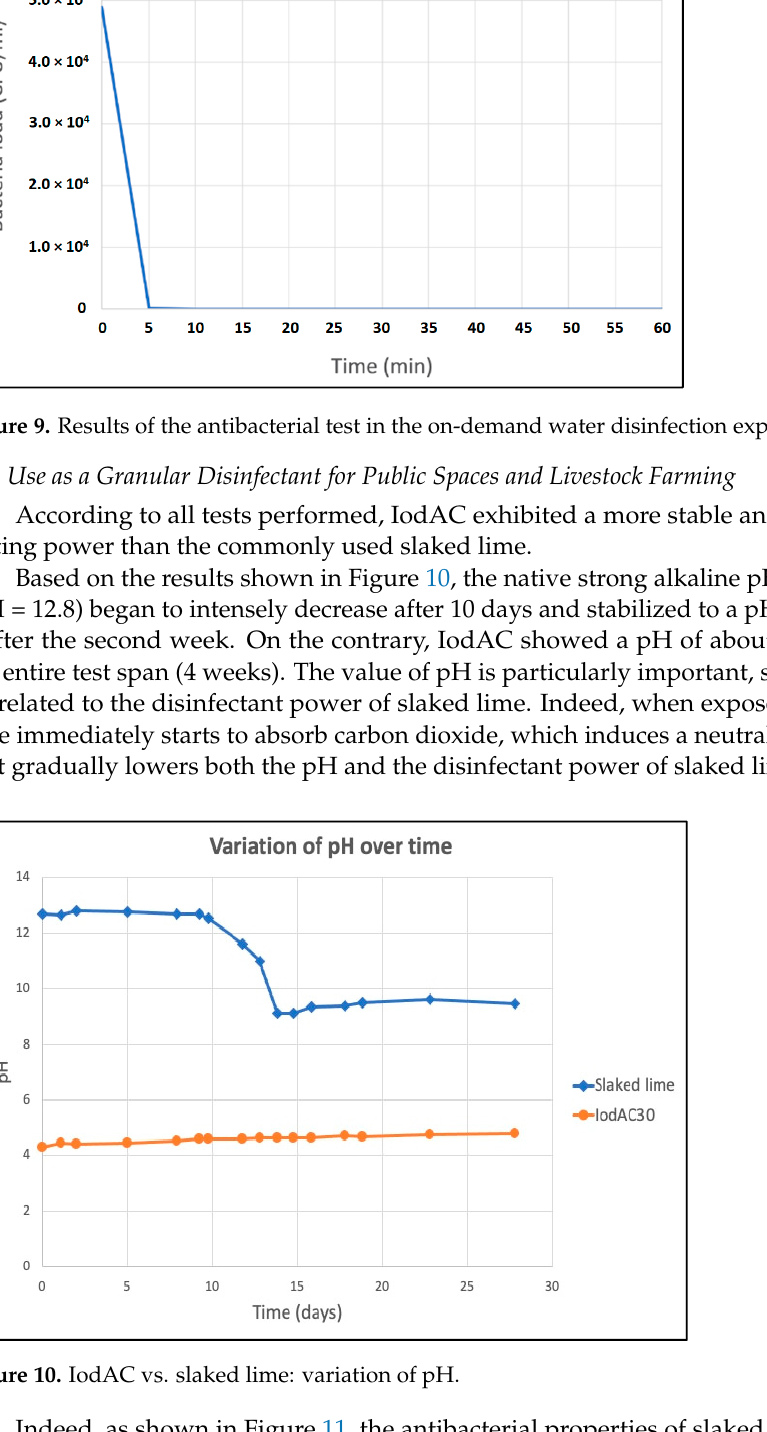
Figure 8. Results of the antibacterial test in the continuous-flow column water disinfection experiment.